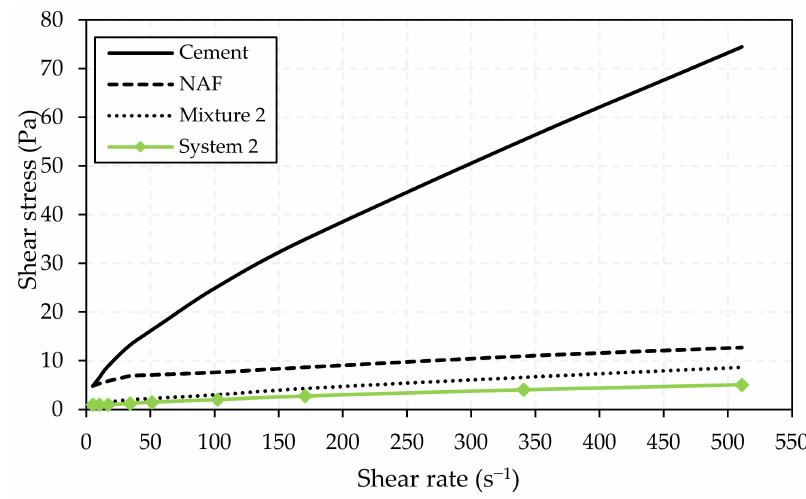
Figure 12. Rheological behavior of cement / NAF / mixture and cleanup fluid: system 2.